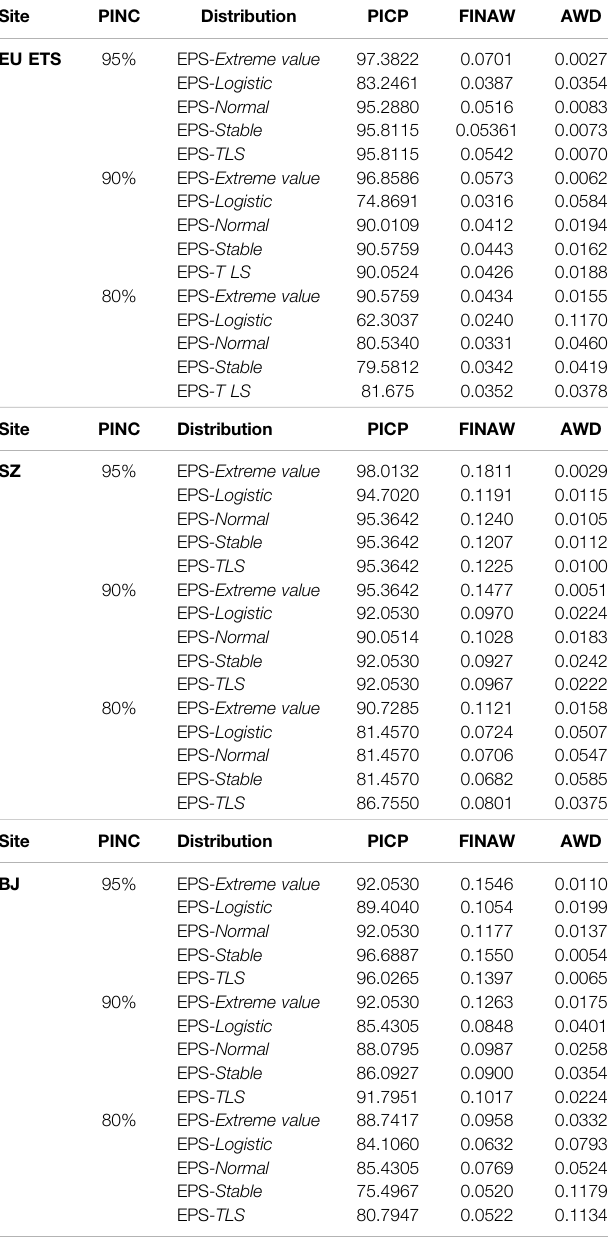
TABLE 10 | Carbon price range prediction results based on EU ETS, SZ, and BJ under different signi fi cance levels. Site PINC